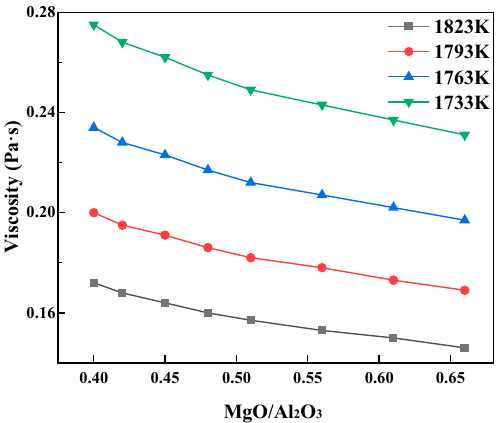
Figure 4. Viscosity curves of high-titanium slag with different MgO/Al 2 O 3 .